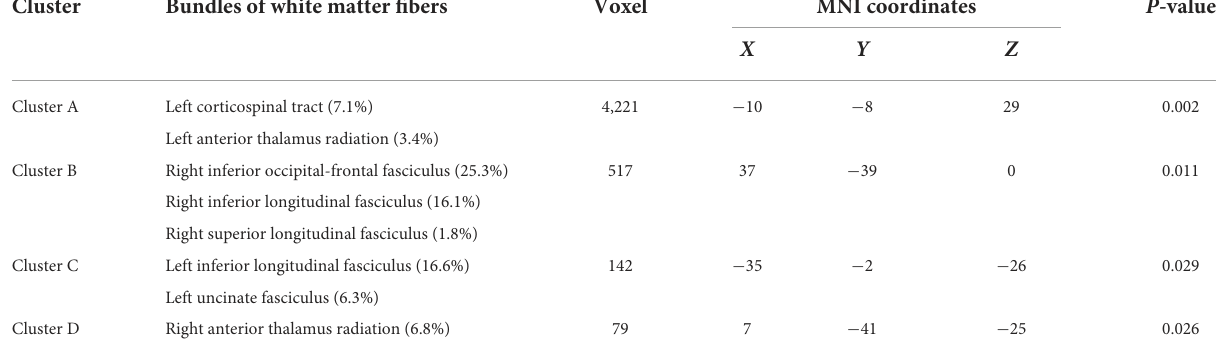
TABLE 3 Main effects of diagnosis on FA among the four